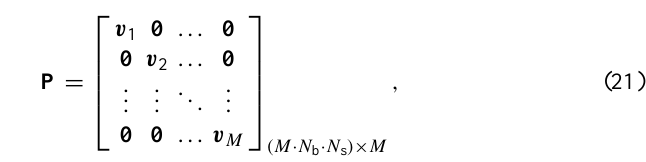
(cid:17) T (cid:0) ( LS ) B ( LS ) T + R (cid:1)